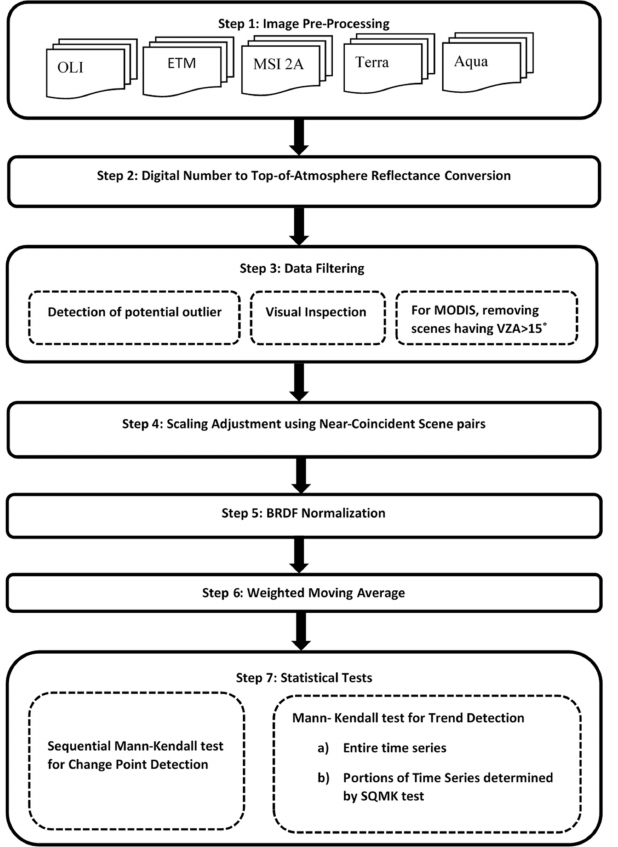
Figure 1. General flowchart for change point detection of PICS. VZA is the View Zenith Angle; BRDF is Bidirectional Reflectance Distribution Function; SQMK is Sequential